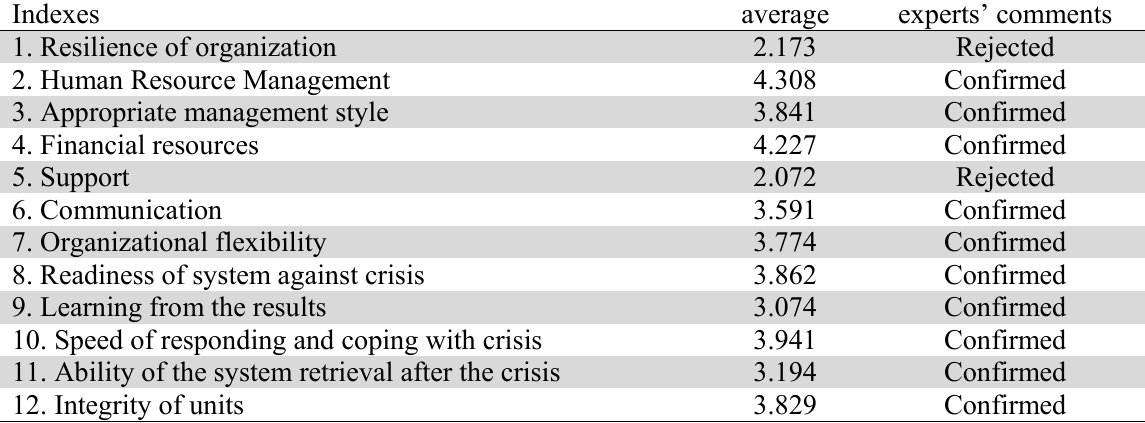
The results of paired comparisons for weighting the criteria